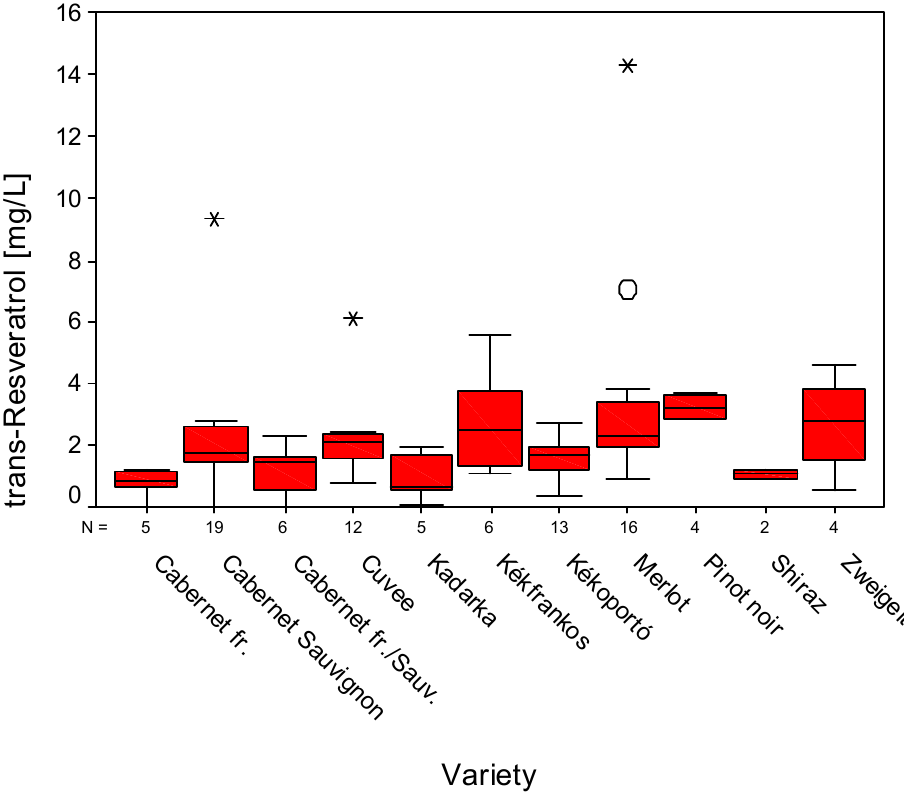
Figure 4. Trans-resveratrol content [mg/L] of Hungarian red wines (n=92) of the “Villány” region according to variety.